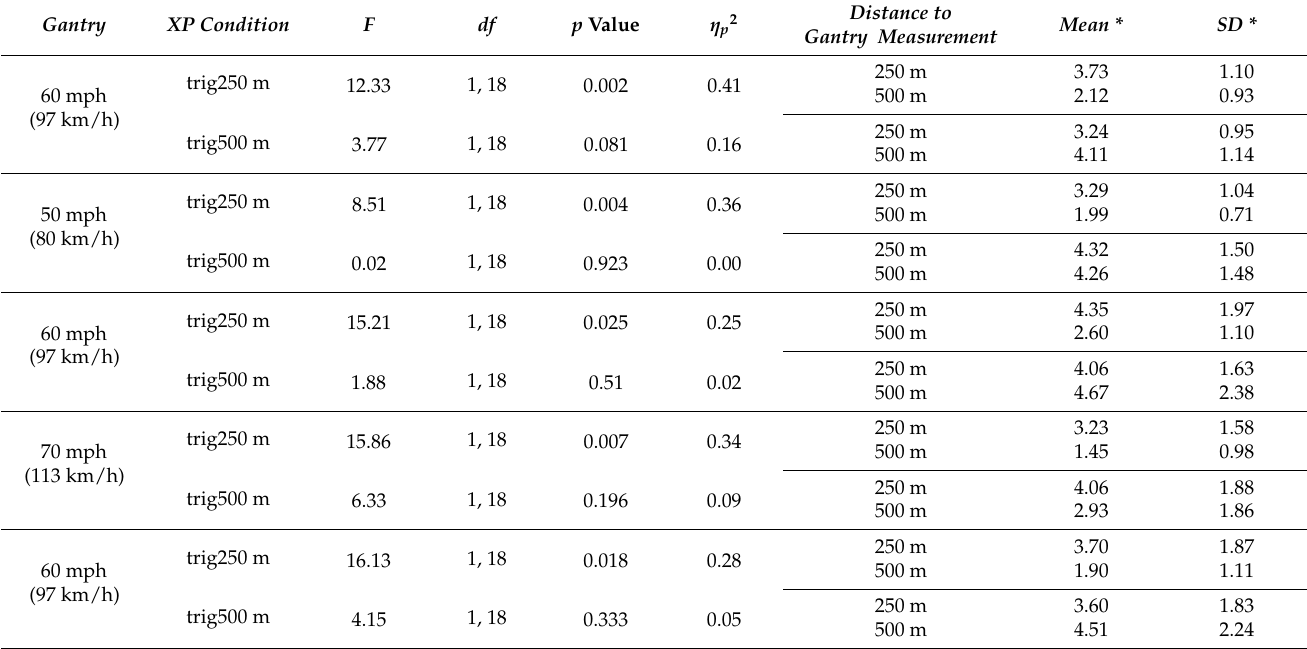
Table 12. Analysis of variance to test the effect of the HMI trigger on speed